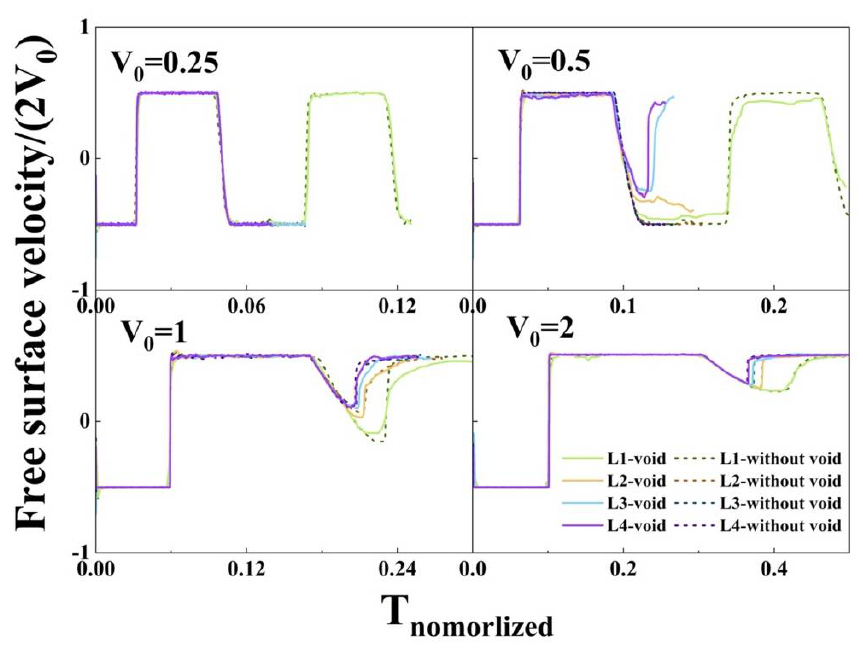
Figure 11. Free surface velocity profile of the samples. Both axes are normalized. T normalized = t × 2 v 0 /L z .